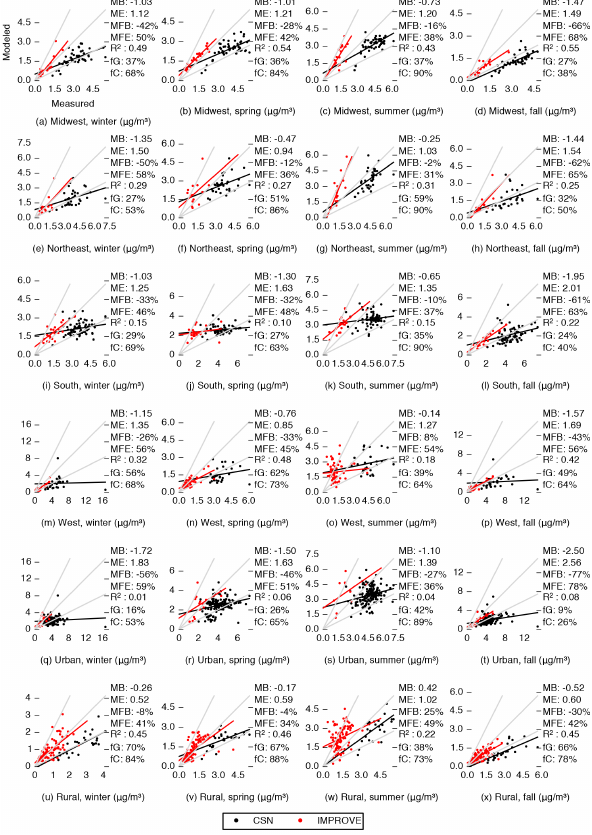
Figure 11. Comparison of modeled and measured particulate OC concentrations, disaggregated by region and